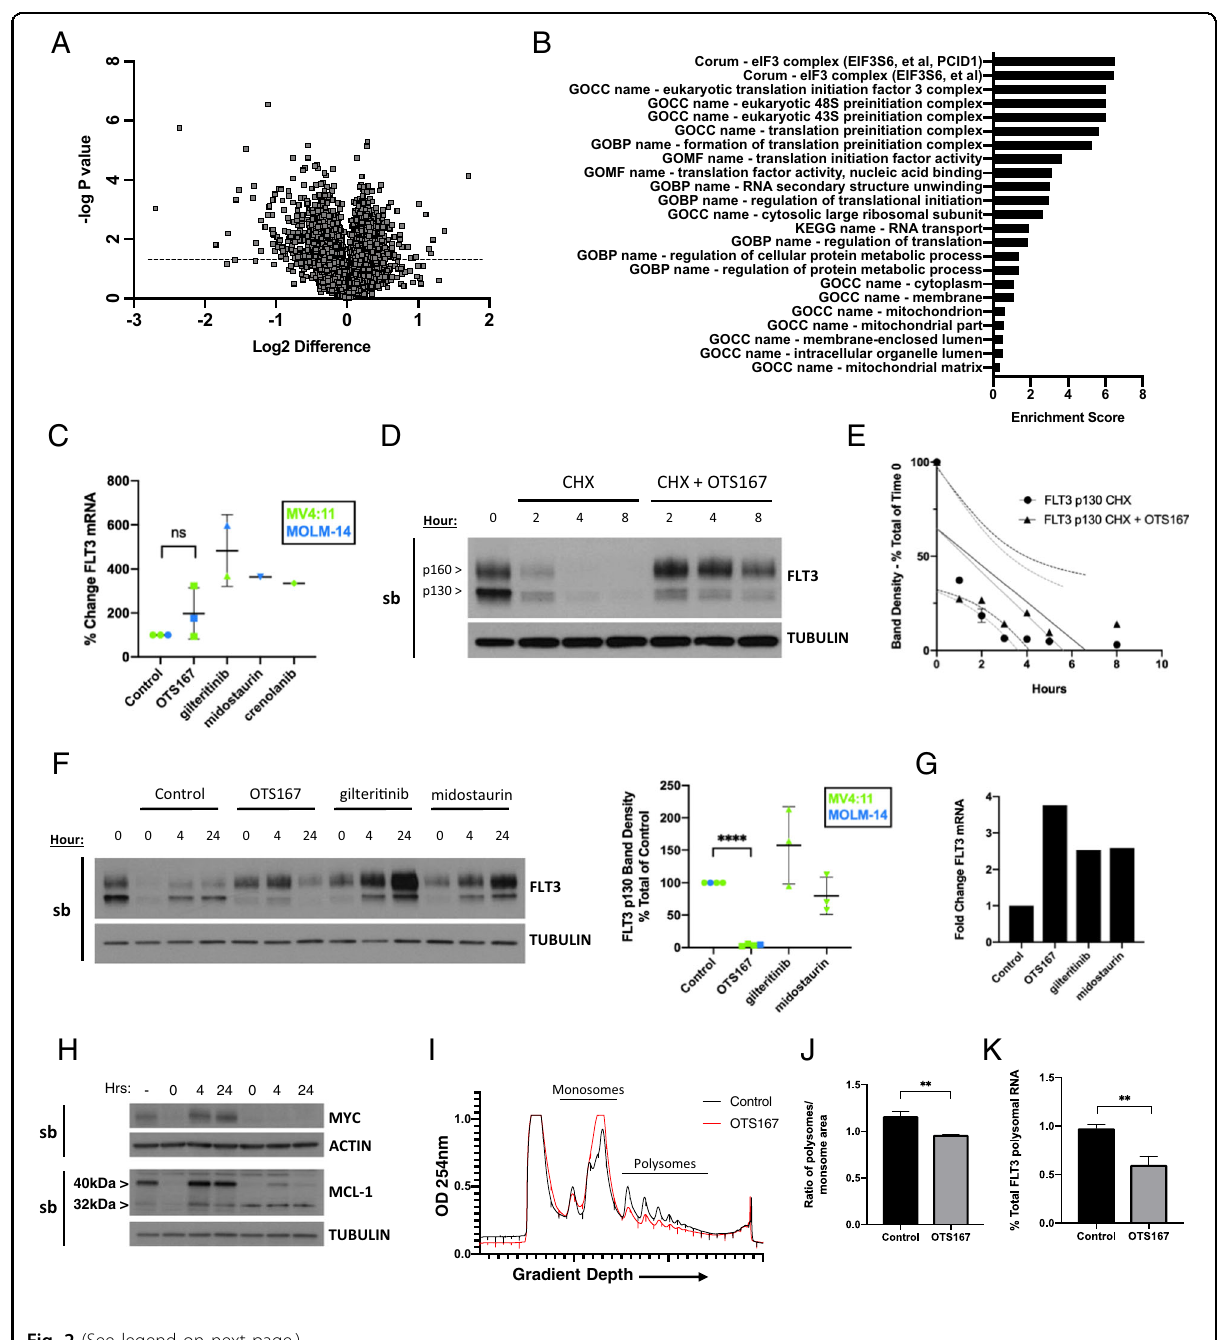
Fig. 2 (See legend on next